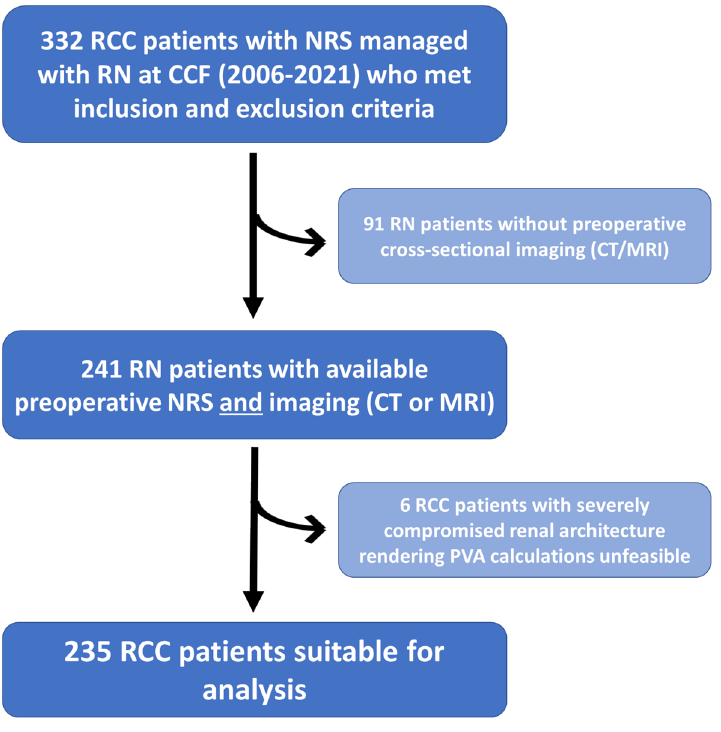
Figure 1. Inclusion and exclusion criteria for the final study cohort of 235 RCC patients managed with radical